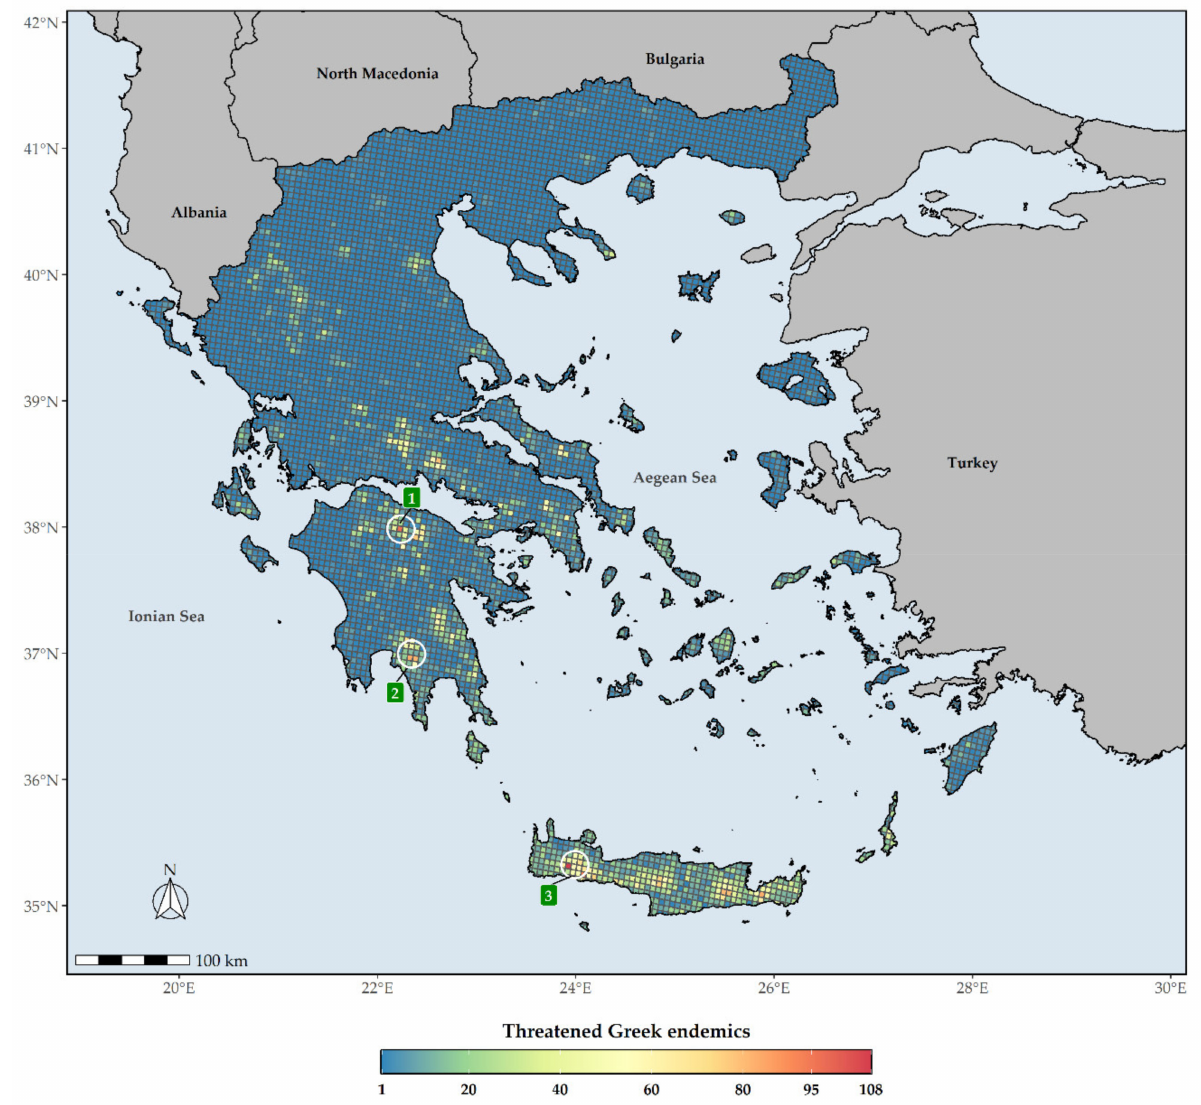
Figure 6. Species richness in Greece regarding threatened Greek endemic taxa (GR) for every grid cell in Greece. Grid cell resolution equals to ca. 5 km. 1: Mt. Chelmos, 2: Mt. Taygetos, 3: Lefka Ori mountain range. The white circles delineate (roughly) the aforementioned mountains and mountain